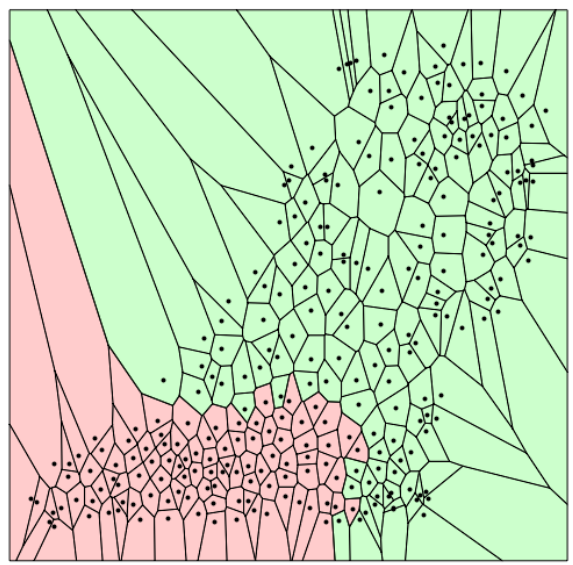
Netherlands and Belgium where the language Dutch is spoken. extend far into Germany, where no Dutch is spoken.